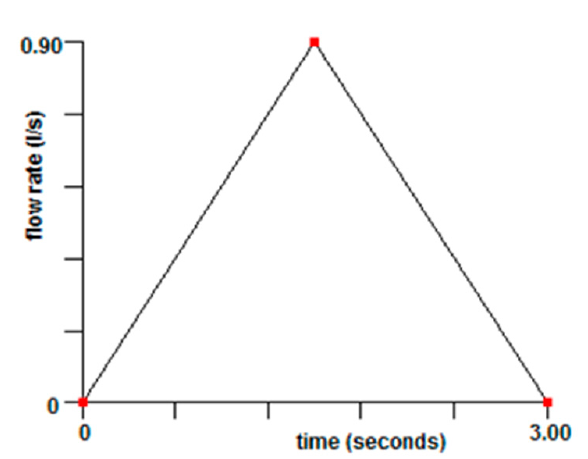
Figure 4. Flowrate against time graph for pour flush.